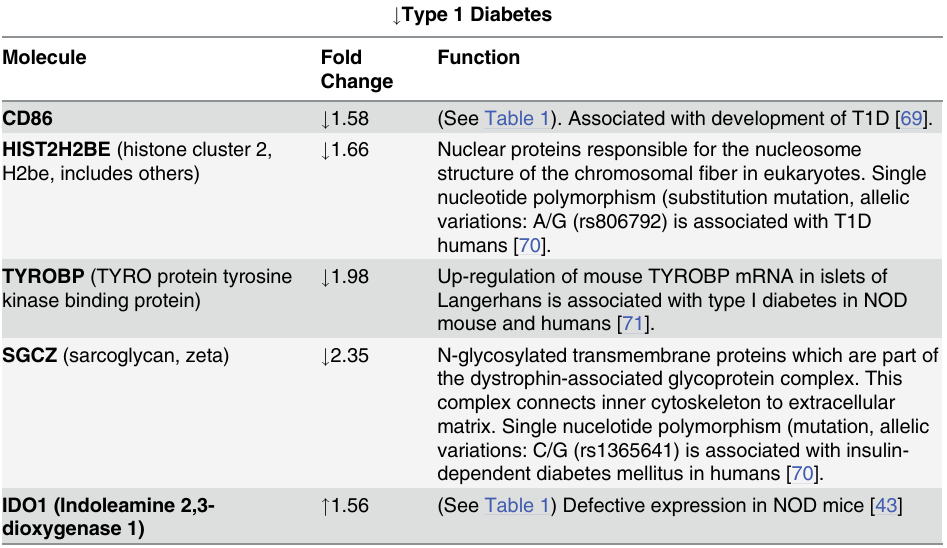
Table 2. Effect of CTB-INS on proteins associated with type 1 diabetes